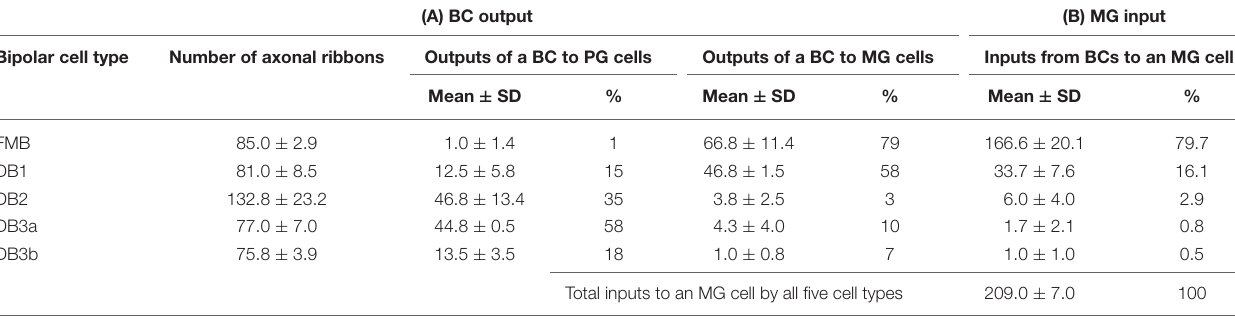
TABLE 3 | Ribbon synaptic contacts of OFF bipolar cell types with parasol and midget ganglion cells. (A) BC output (B) MG input